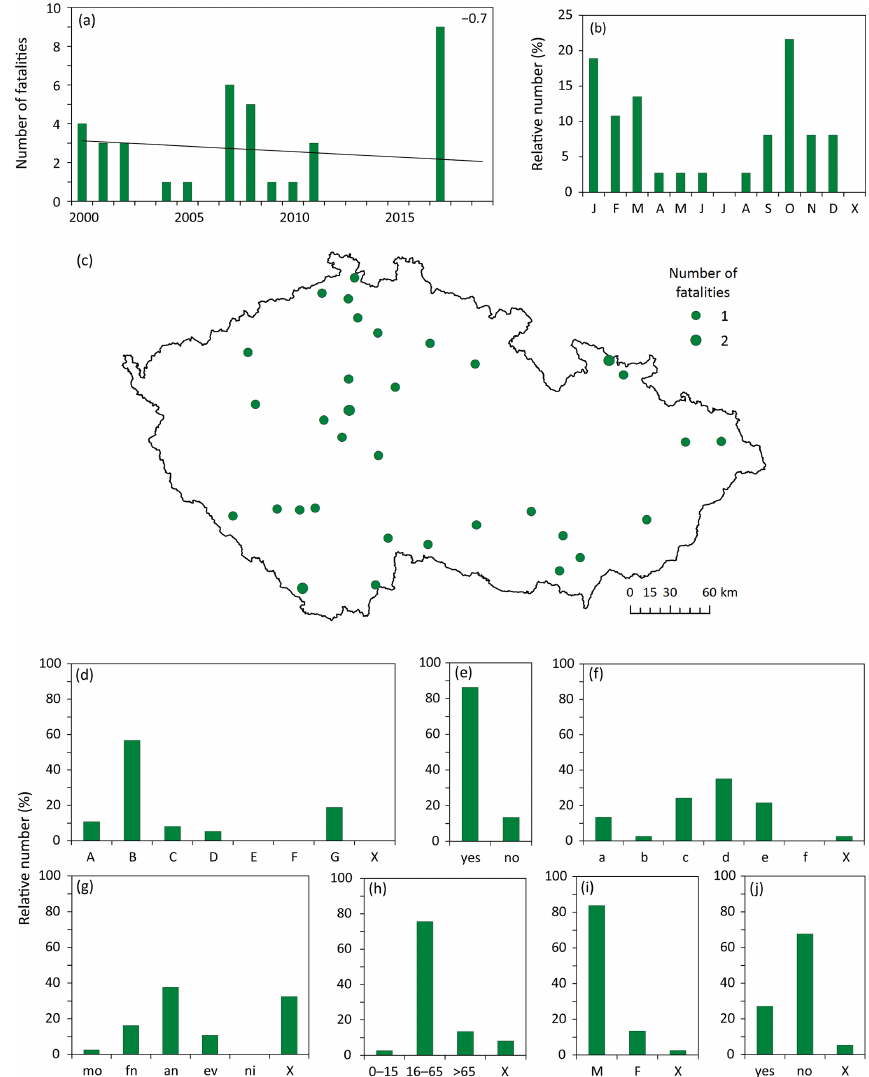
Figure 2. Characteristics of windstorm-related fatalities in the Czech Republic during the 2000–2019 period: (a) fluctuation with linear trend (top right, fatalities/10 years), (b) annual variation, (c) spatial distribution, (d) cause of death, (e) type of fatality, (f) place of death, (g) part of the day, (h) age, (i) sex, (j) behaviour. For explanation of symbols and abbreviations see Fig.